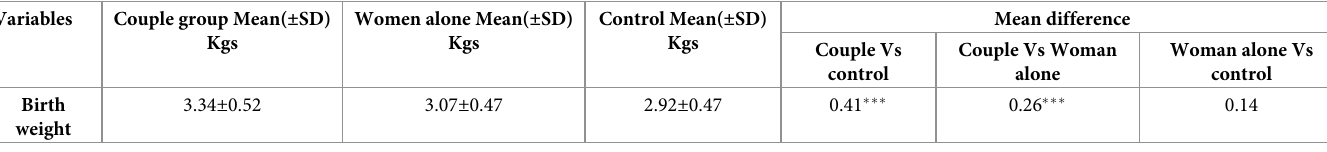
Table 4. Comparison of the newborn babies’ mean birth weight among the intervention and control group, Illu Aba Bor, Zone, Southwest Ethiopia, 2019/20. Variables Couple group Mean( ± SD)